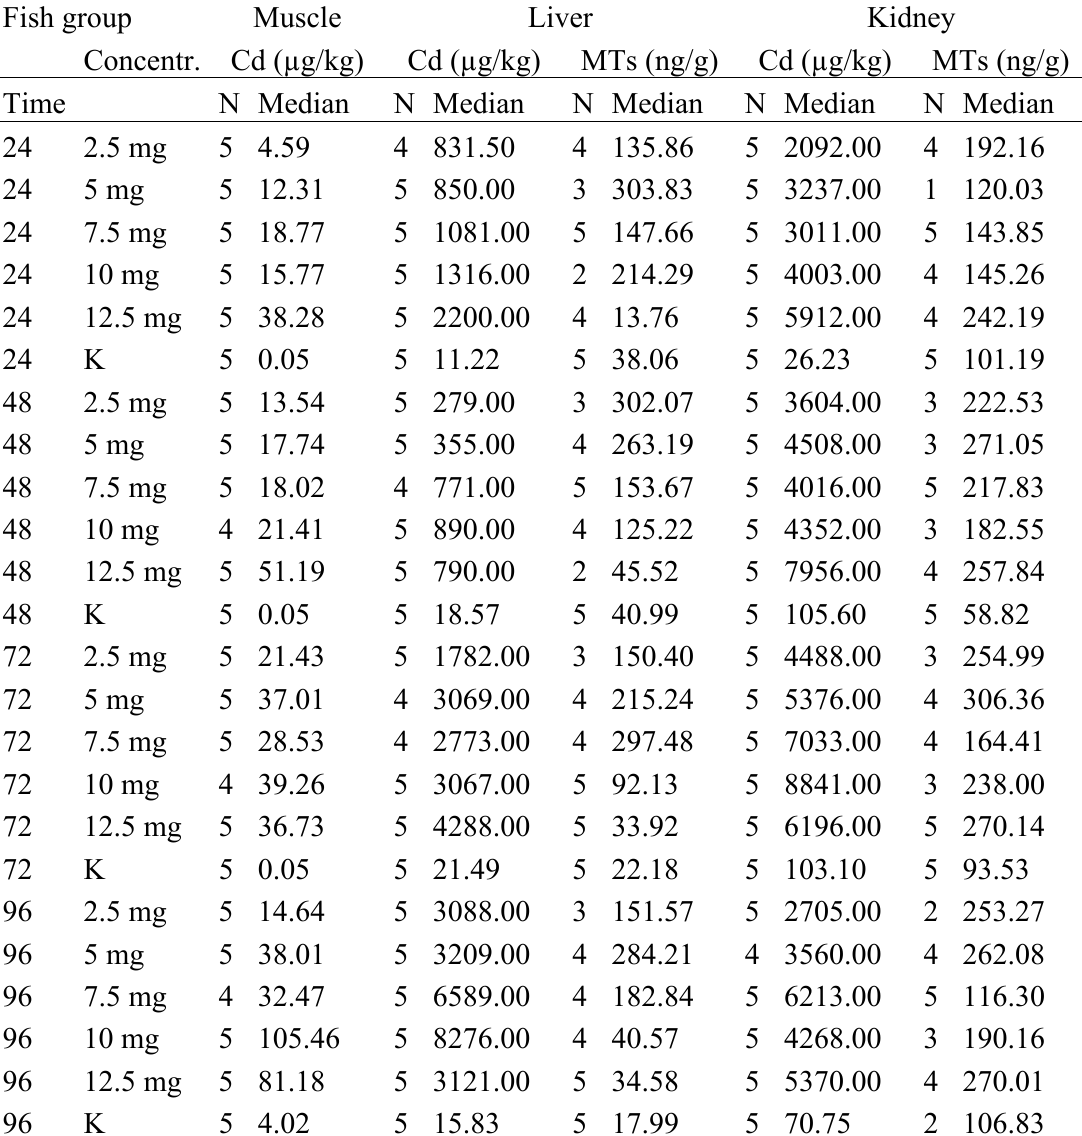
Table 1. Cadmium content in muscle, liver and kidney, MTs in liver and kidney in fish groups exposed to different concentration of cadmium chloride for a specific time